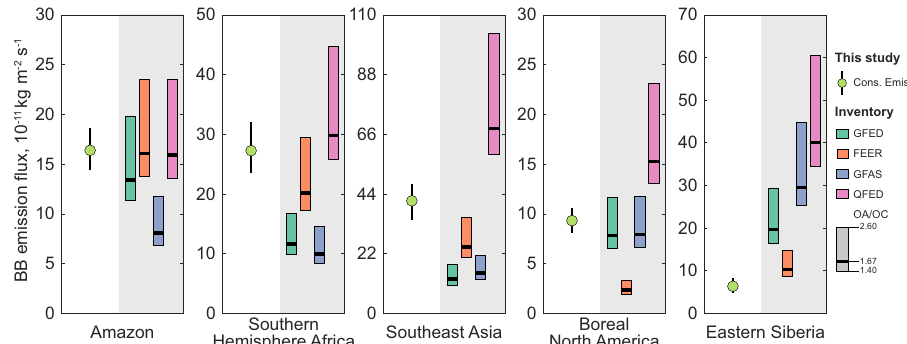
Fig. 3 | Comparisons of biomass burning emission fl ux between this study and fouremissioninventories. The constrainedBBemissions(Cons.Emis.)are shown with interquartile ranges (error bars) resulting from the eight uncertainty factors (see Supplementary Fig. 4).TotalBBemissions consist of OA, BC, and SO 2 . TheOA emissions in the four inventories are converted from OC emissions with a ratio rangingfrom1.4to2.6asusedintheAeroCommodels(shownastherangeofbars).